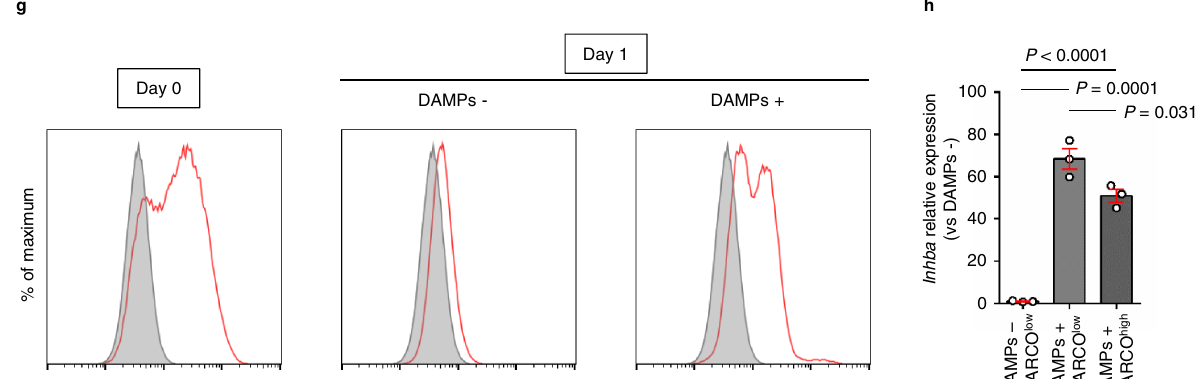
by fi tting the expression distribution with Gaussian mixture distribution. g , h In vitro culture of mouse primary AMs from bronchoalveolar lavage fl uid with or without damage-associated molecular pattern molecules (DAMPs) from LLC cells. g FlowcytometryhistogramofAMswithMARCO.Shadedregionsindicatestaining with only the second antibody (i.e., without the anti-MARCO antibody). h RT-PCR analysis of Inhba expression in AMs after in vitro culture for 1day with or without DAMPs ( n =3 per group). Means±s.e.m. for each group are shown. Symbols represent individual wells ( h ). Statistical signi fi cance was determined using one- way ANOVA with Bonferroni ’ s post hoc test ( h